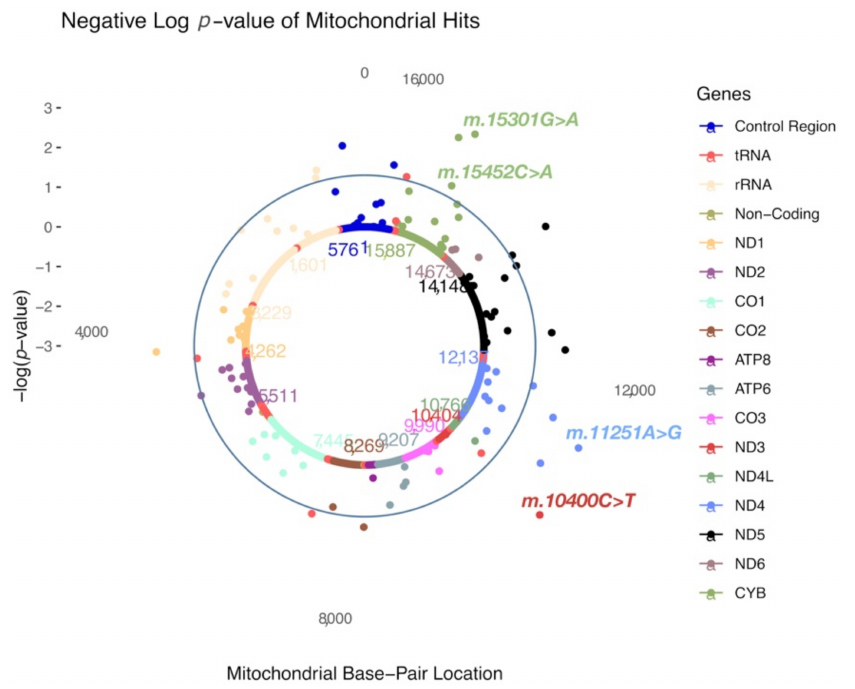
Figure 3. A solar plot of SOFT CAD common and low-frequency (MAF > 0.01; n = 111) MT-SNV associations. CR = control region.